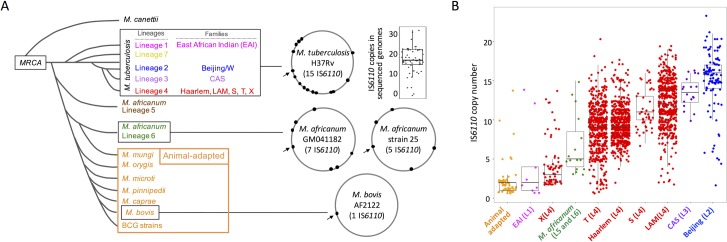
IS6110 in the MTBC.(a) Schematic phylogenetic relationships of MTBC members arisen from a most recent common ancestor (MRCA) after an evolutionary bottleneck. For M. tuberculosis different lineages and families are indicated. The position of IS6110 sequences in fully assembled genomes in indicated by black dots. The arrow indicates the position of IS6110 in the Direct Repeat region of the CRISPR-Cas locus, which is common to most MTBC strains. For the remaining 17 M. tuberculosis strains different from H37Rv, the number of IS6110 sequences is indicated by a box plot (median = 17). (b) Box plots showing the IS6110 copies in MTBC families. For each family, the lineage according to panel (a) is provided in parenthesis in the X-axis. For clarity, L4 have been subdivided into 5 different families according to spoligotyping.